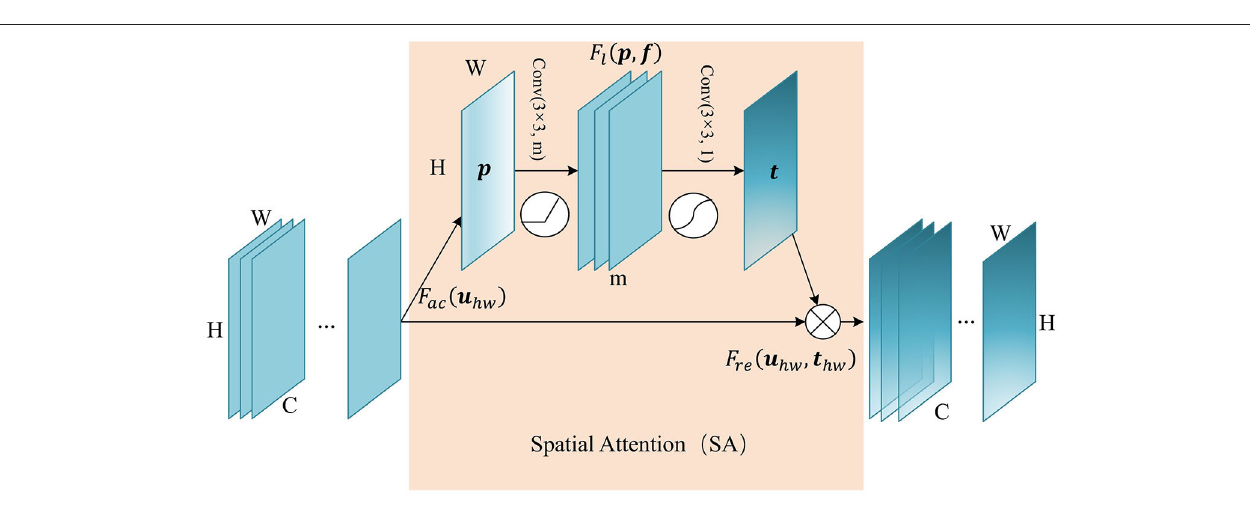
FIGURE 2 | The structure of Spatial Attention (SA) module. The aggregate function F ac generates a spatial descriptor p ∈ R H × W . Self-learning function F l implemented by two convolutional layers generates the spatial weights map t ∈ R H × W . Finally, function F re uses t to generate the output of the SA module.